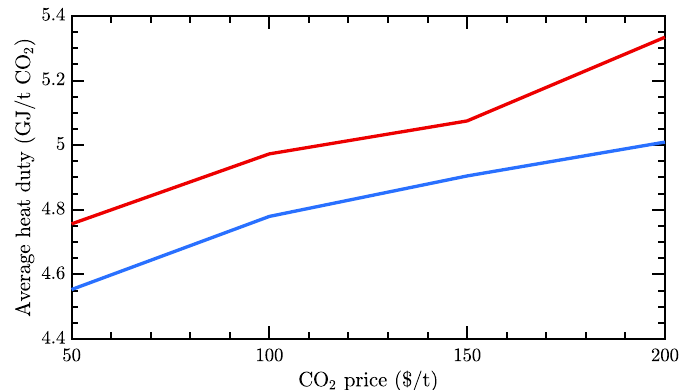
Figure 10. Average heat duty of the controllers under scenario 1 at different CO 2 prices. EMPC (blue), MPC (red).